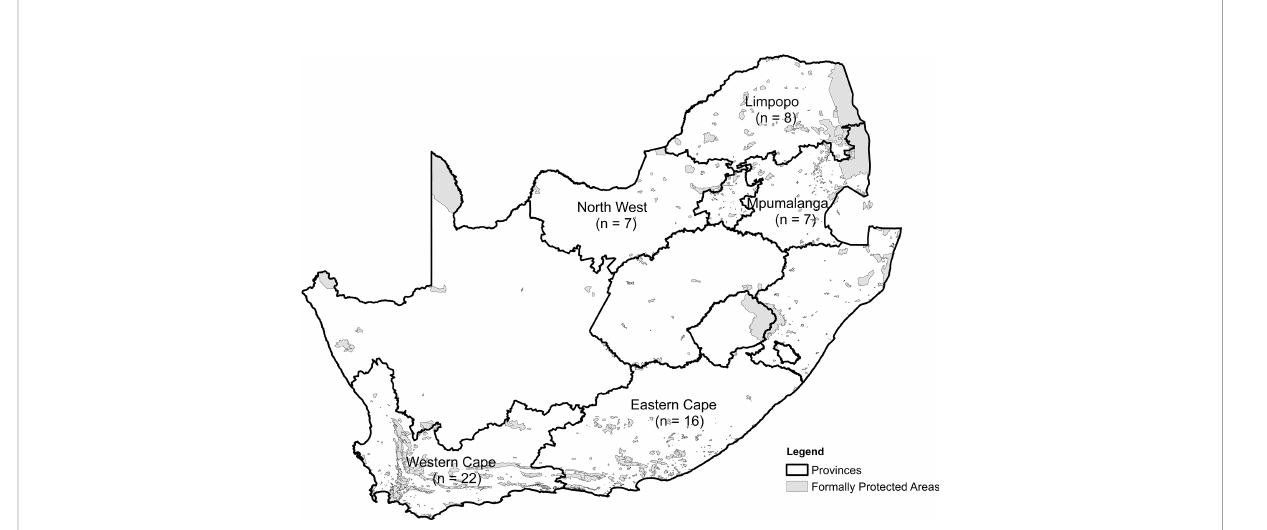
FIGURE 1 Distribution of reported translocated leopards within fi ve provinces in South